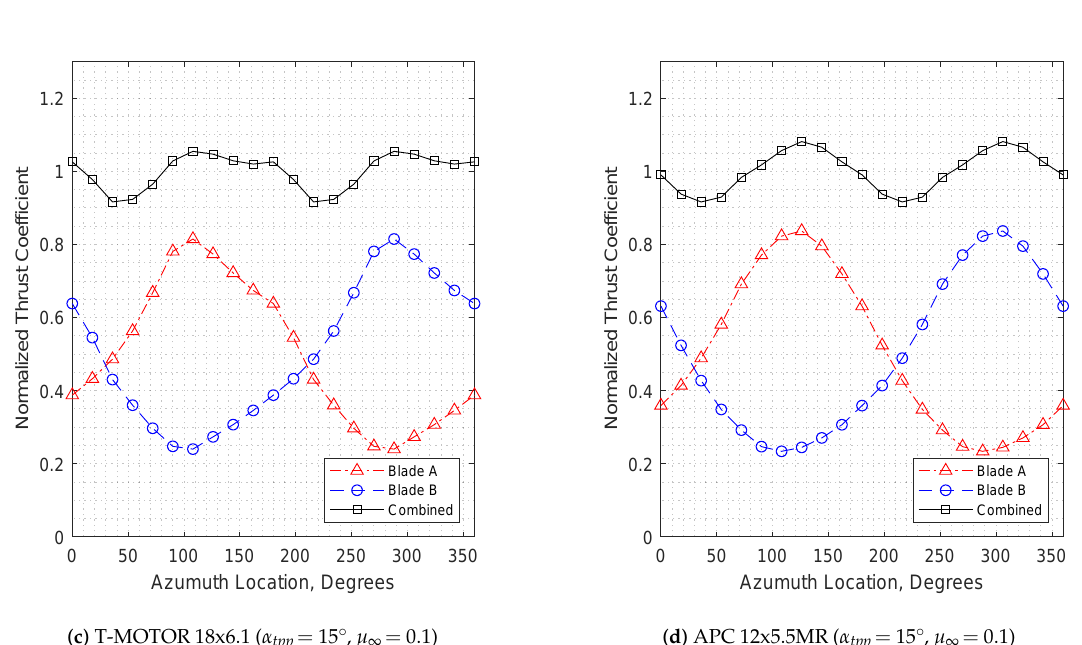
( c ) T-MOTOR 18x6.1 ( α tpp = 15 ◦ , µ ∞ = 0.1)